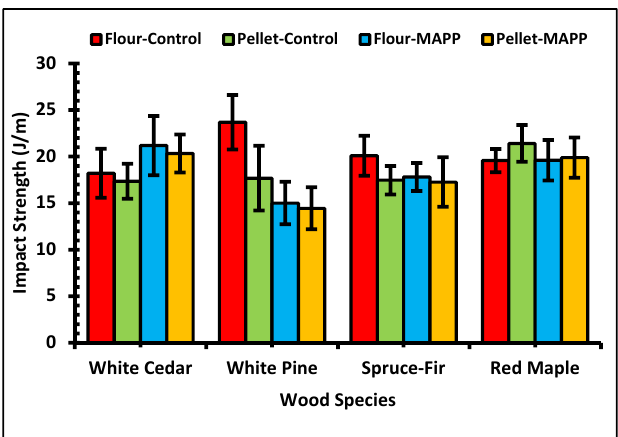
Figure 7. Impact strength of WPCs.